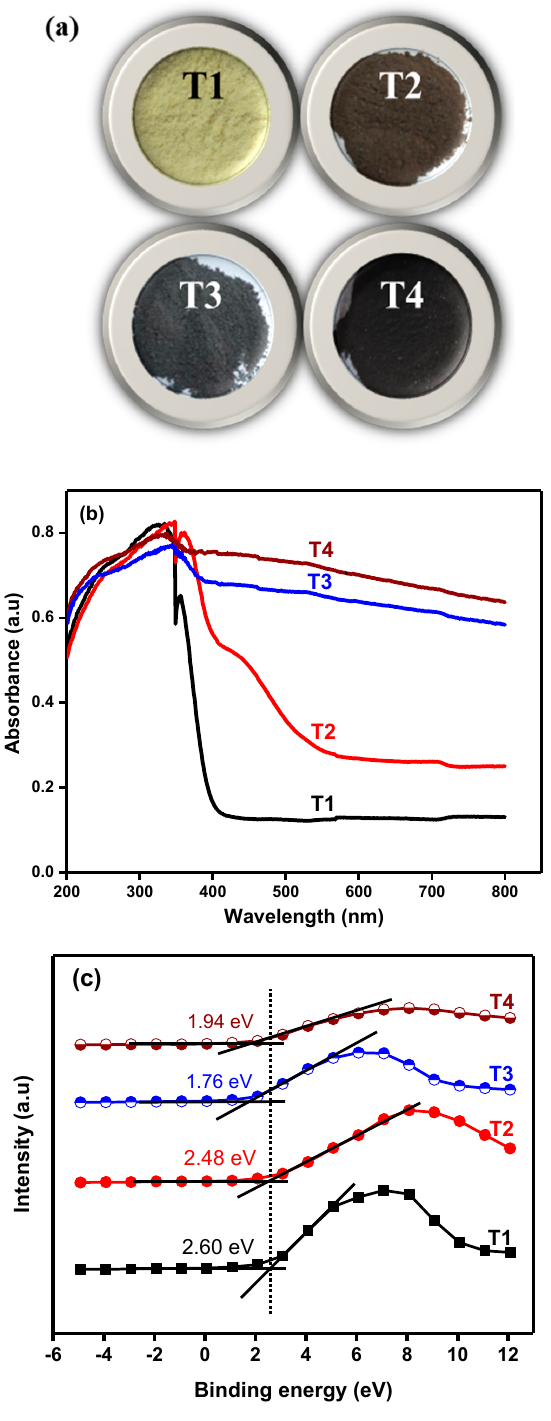
Figure 3. ( a ) Photographs, ( b ) DR UV-Vis absorption spectra, and ( c ) valence band positions of colored TiO 2 NPs prepared at various glycerol concentrations and calcined at 300 °C.